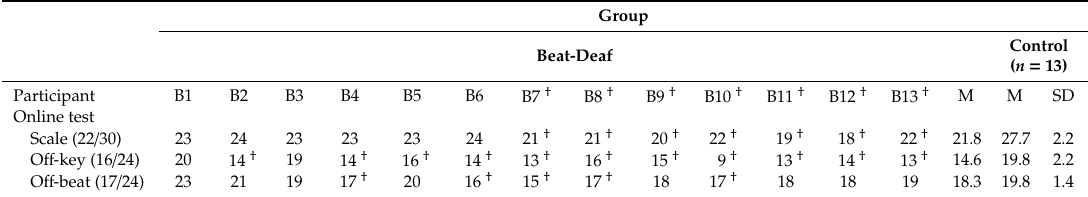
Table 2. Individual scores of the beat-deaf participants and the group average of their matched controls in the online test of amusia.